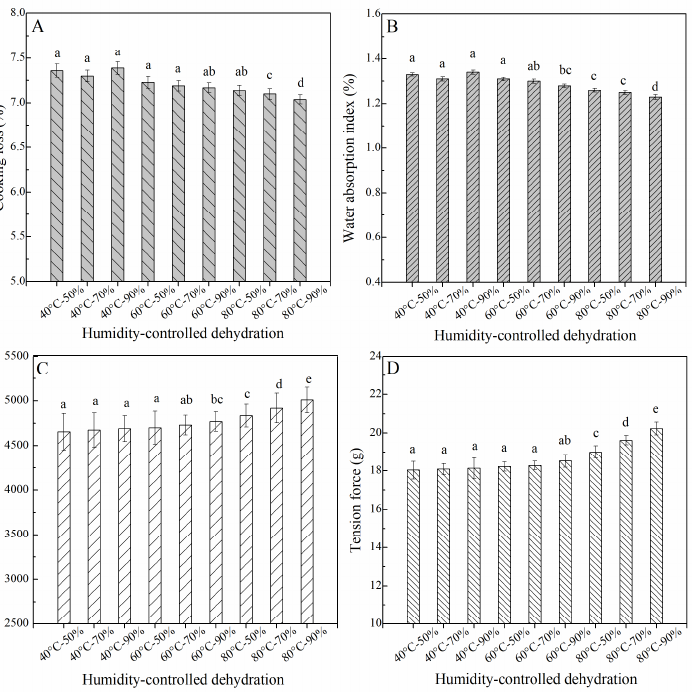
Figure 4. Effect of humidity-controlled dehydration on the textural and cooking quality of fresh wet noodles. ( A ), hardness; ( B ), tension force; ( C ), cooking loss; ( D ), water absorption index. 40 °-50%, fresh wet noodle samples treated by humidity-controlled dehydration under the condition of 40 °C and RH of 50%, etc.